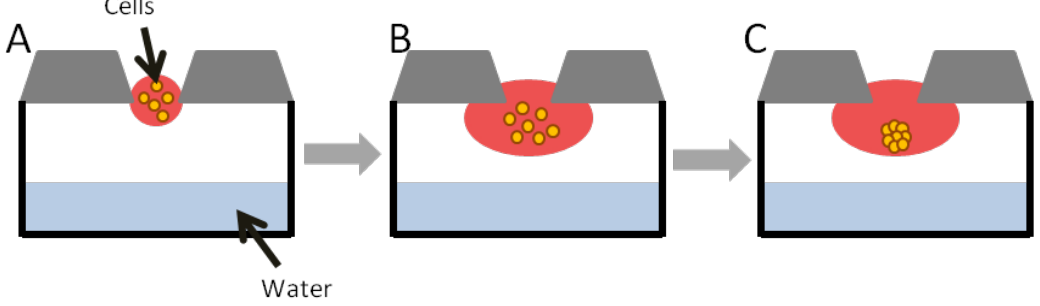
Figure 2. Spheroid formation in hanging drop method: ( A )—cell suspension dispensed; ( B )—cells in hanging drop; ( C )—cells aggregate to form spheroid [29].